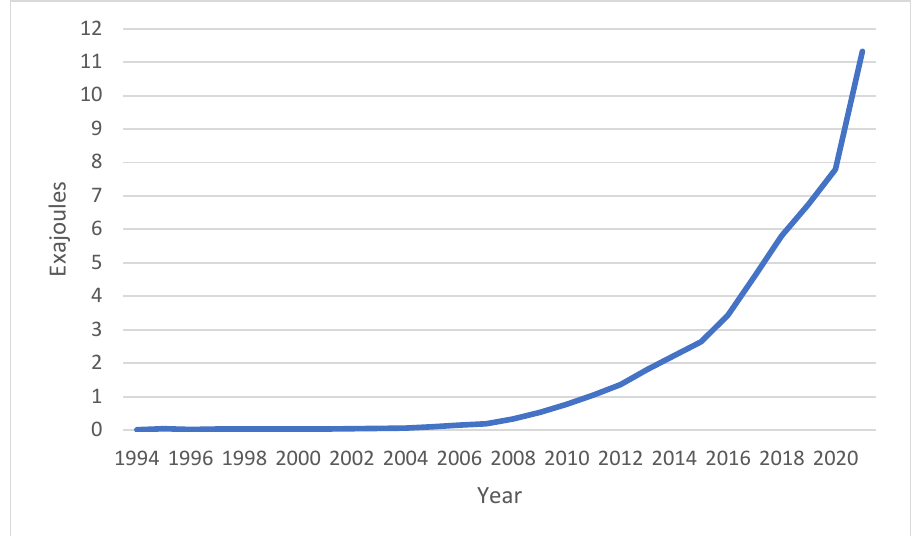
Figure 3. Renewable energy consumption in China.